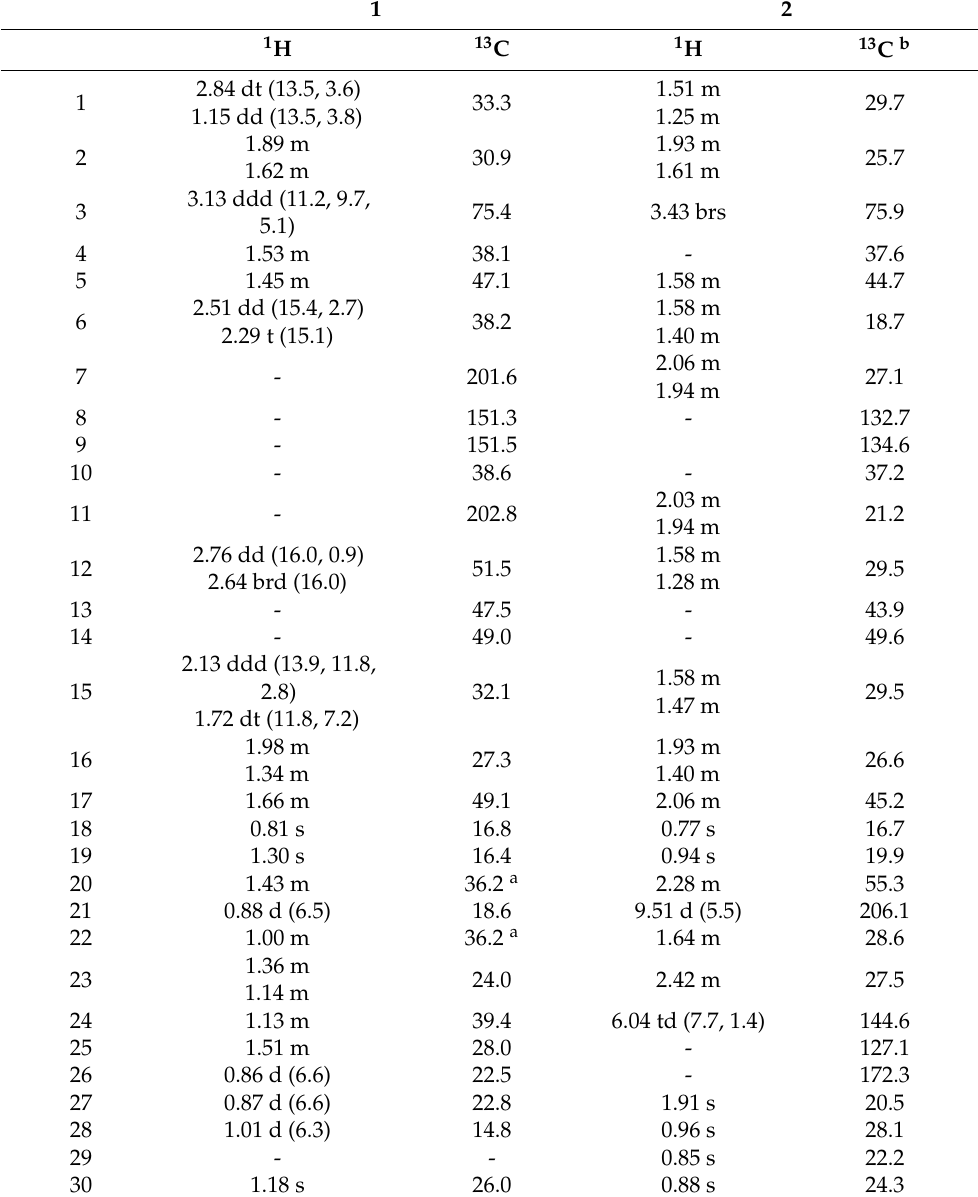
Table 1. 1 H and 13 C NMR data for 1 and 2 in CDCl 3 ( 1 H at 600 MHz, 13 C at 150 MHz, δ in ppm, J in